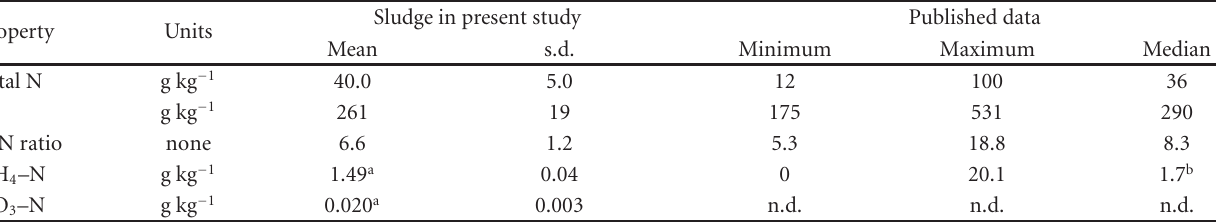
Table 1: Comparison of determinations for the textile wastewater sludge ( n = 4) to wastewater sludge materials ( n = 17) reported [24] for analyses on a dry-mass basis for total C and N, C/N ratio, ammonium-N, and nitrate-N; s.d. = standard deviation; n.d. = not determined.